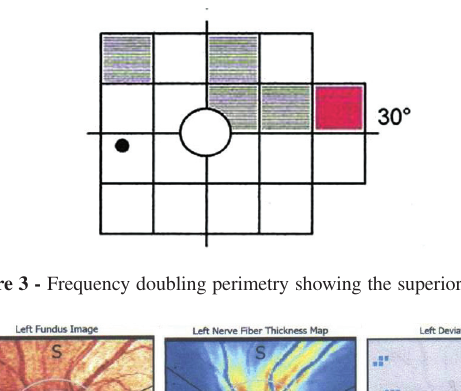
Figure 2 - Visual field of the same eye above, showing the superior defect